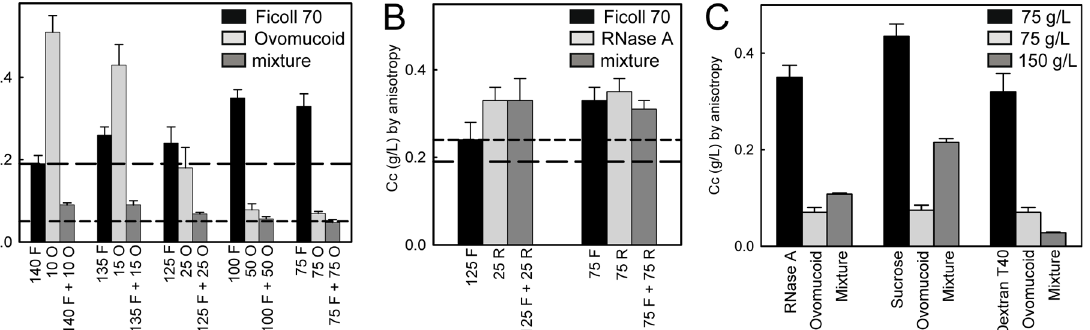
Fig 3. Effect of mixtures involving protein crowders on the polymerization of FtsZ. (A) and (B) Cc values determined in the presence of the specified crowders and their mixtures up to a total crowder concentration of 150 g/L (whole set of values in Table 2). In the x axis, F, O and R are Ficoll 70, ovomucoid and RNase A, respectively, and the numbers correspond to their concentration alone or in the mixtures, in g/L. Long and short dashed lines correspond to the Cc values in the presence of 150 g/L Ficoll (A and B) and ovomucoid (A) or RNase A (B), respectively. (C) Cc of FtsZ assembly in the presence of the individual crowders specified in the figure and their mixtures (50%). Values correspond to the average ± SD of at least three independent